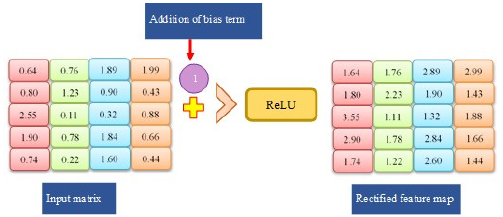
Figure 7. Applying Relu Function and addition of bias term.